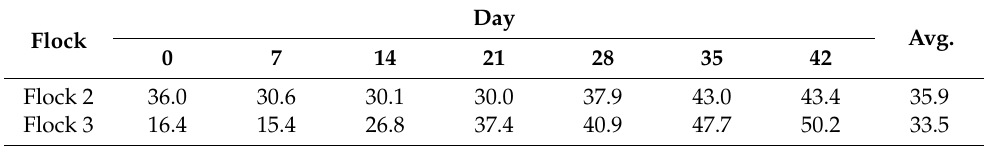
Table 2. Average litter moisture (%) flock 2 and 3 by treatment by day.